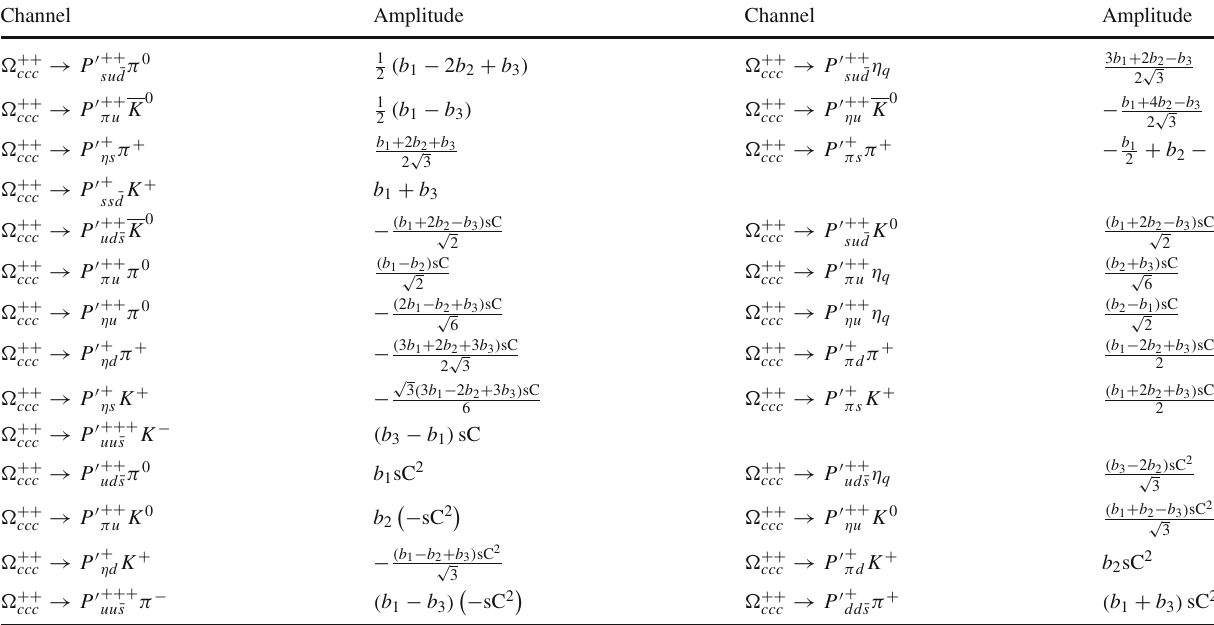
Table 3 The production of pentaquark P 15 ( cc ¯ qqq ) from triply heavy baryon (cid:2) ccc Channel Amplitude Channel